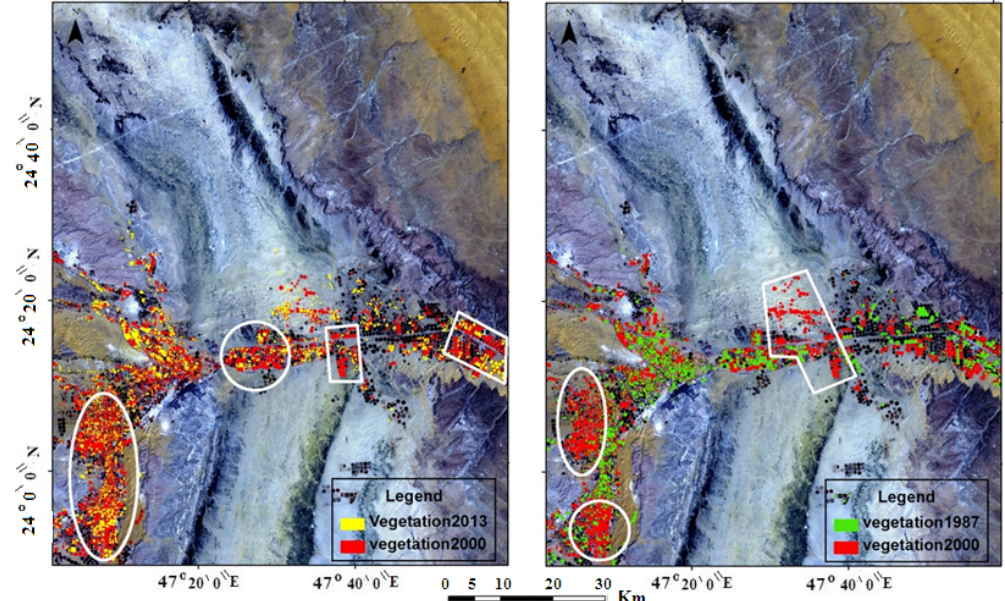
Figure 6. Change detection of vegetation cover: an increase observed between 1987 and 2000 and a decrease between 2000 and 2013.